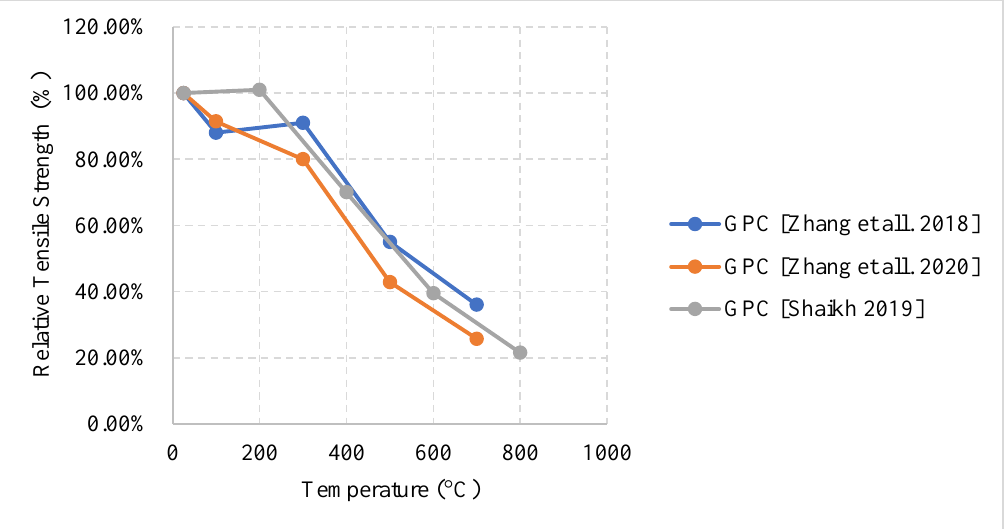
Figure 38. Relative tensile strength of naturally cooled GPC with different constituents [43,117,118].